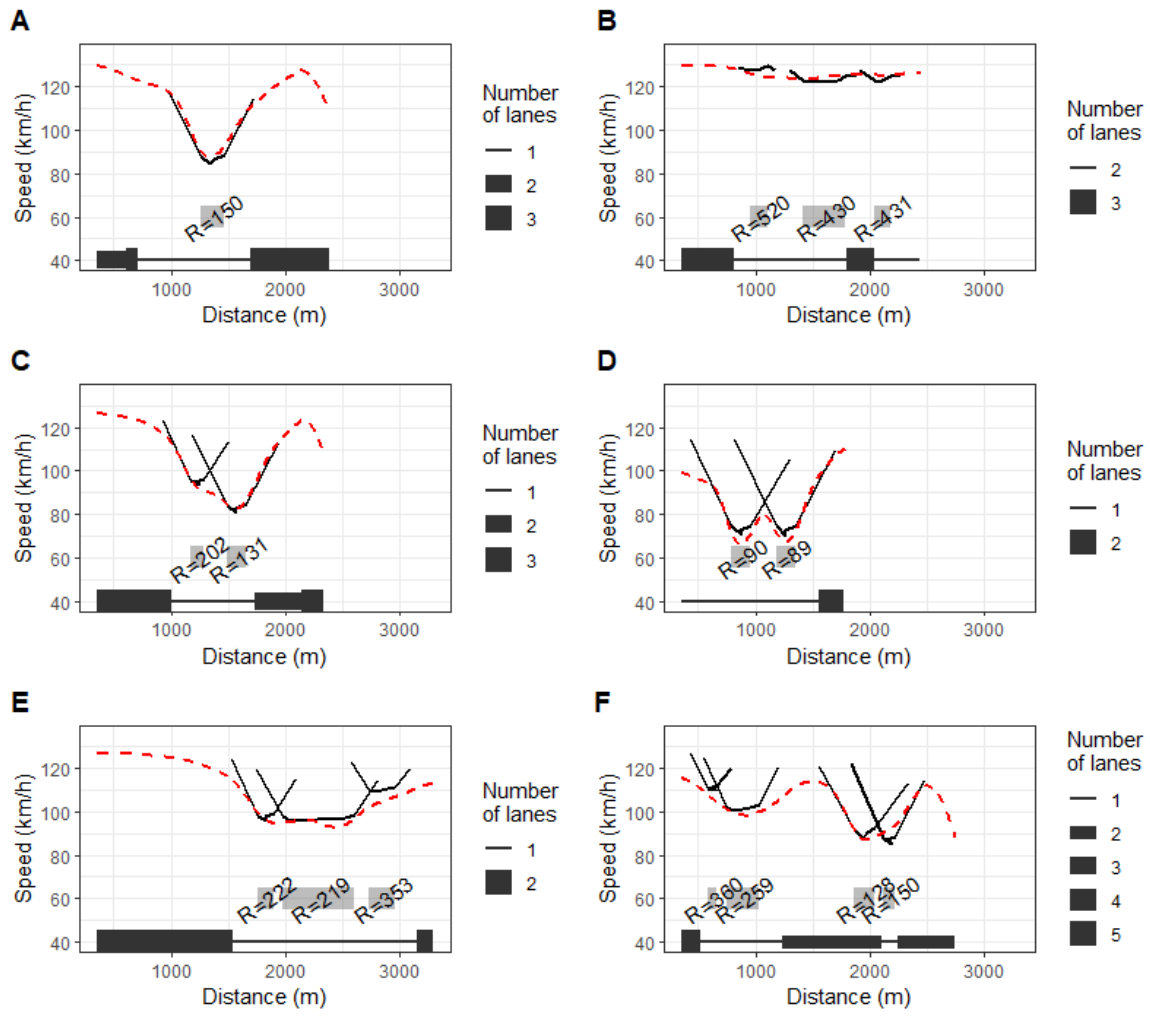
Figure 8. Observed and predicted speed profiles; red dashed line is the observed 85 th percentile speed, the black lines are the predicted speed profiles per curve. Curve radii in a grey box representing the position of the curve. Below that a line indicating the number of lanes present along the